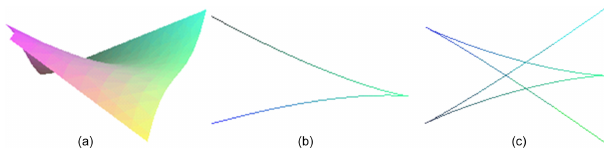
Figure 4. The surface of a fold and its bifurcation